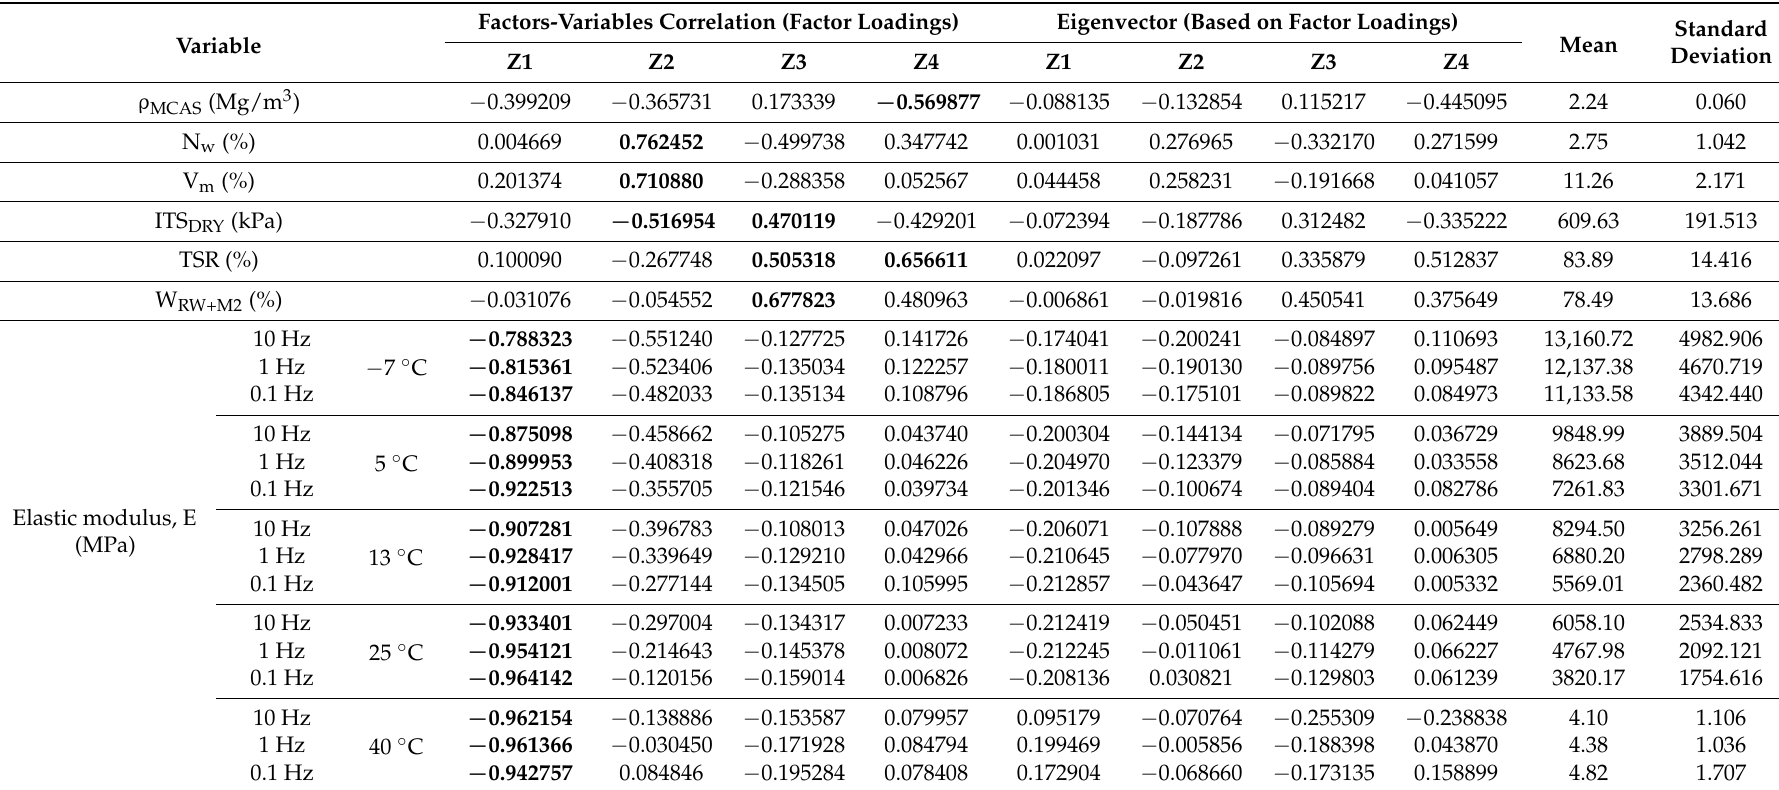
Table 3. Correlation and eigenvector between the factors and real